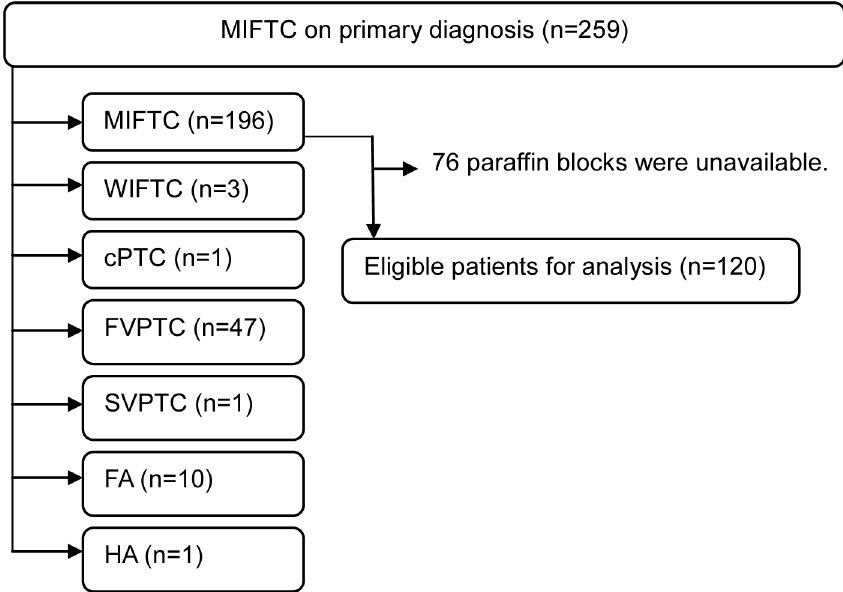
Fig 1. The algorithm of selection for eligible patients in this study. All H&E slides were reviewed by an experienced pathologist (DE Song). FA, follicular adenoma; cPTC, classical papillary thyroid carcinoma; FVPTC, follicular variant papillary thyroid carcinoma; HA, Hurthle cell adenoma; SVPTC; solid variant papillary thyroid carcinoma; WIFTC, widely invasive follicular thyroid carcinoma.